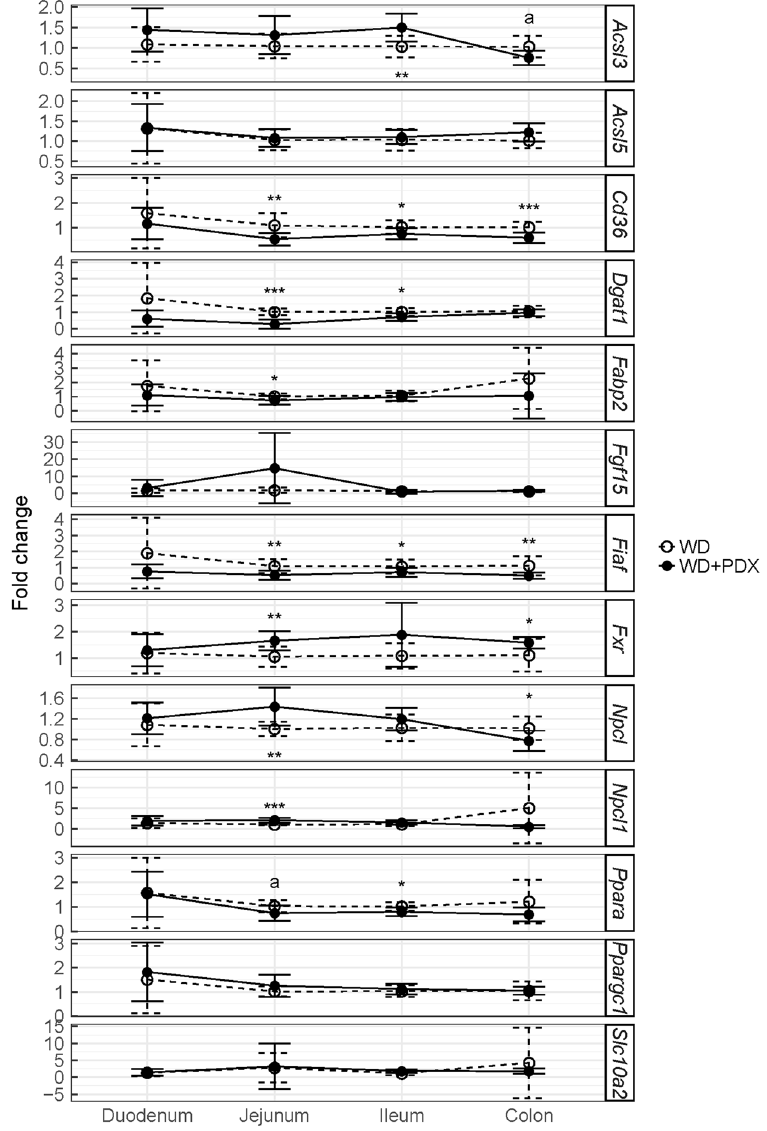
Figure 2. Gene expression analysis of Acsl3 , Acsl5 , Cd36 , Dgat1 , Fabp2 , Fgf15 , Fiaf , Fxr , Npcl , Npcl1 , Ppara , Ppargc1 and Slc10a2 in duodenum, jejunum, ileum and colon. Dgat1 , Cd36 , Fiaf and Fxr showed consistent statistically significant differences between WD and WD + PDX mice in jejunum, ileum and colon. Npcl1 , Npc1 , Acsl3 , Fabp2 and Ppara showed statistically significant difference either in jejunum or ileum or colon between WD and WD + DX mice. The letter “a” represents nearly significant changes. The values are presented as mean ± SD. * p ≤ 0.05, ** p ≤ 0.01, *** p ≤